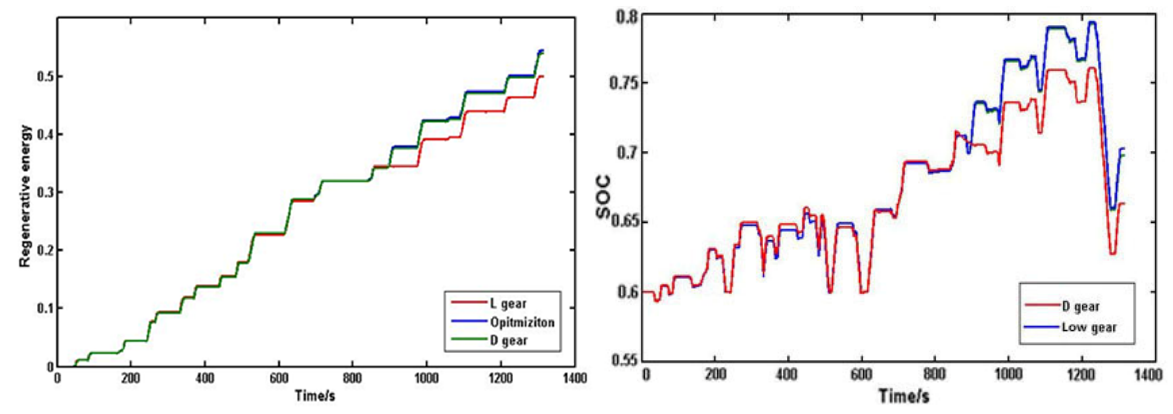
Figure 19. Simulation results. Table 4. Different regeneration energy values under different braking